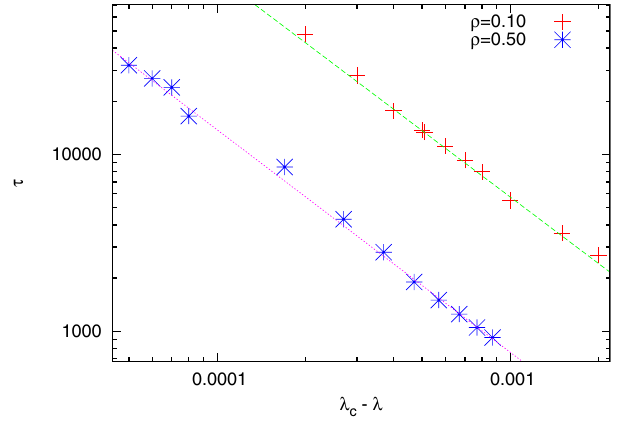
Fig. 4. Variation of relaxation time with (cid:2) at critical points for di®erent values of (cid:1) ¼ 0 : 50 and (cid:1) ¼ 0 : 10 , the value of z is 1 : 25 (cid:5) 0 : 01 for both values of (cid:1) .